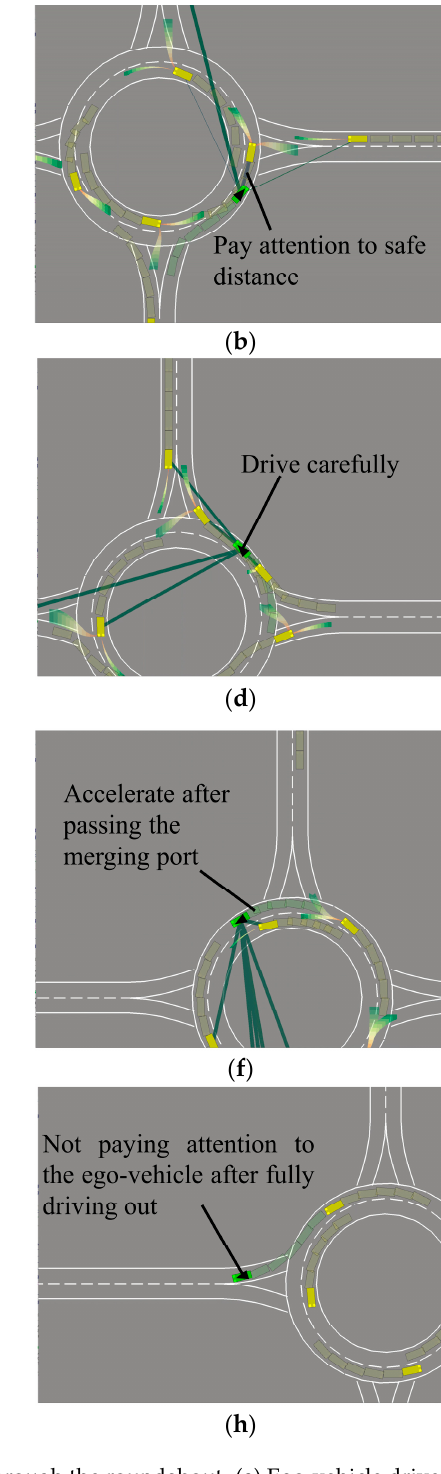
Figure 13. IP-SAC policy control ego-vehicle through the roundabout. ( a ) Ego-vehicle drive into the roundabout. ( b ) Ego-vehicle follow the front vehicle. ( c ) Ego-vehicle focus on incoming vehicles. ( d ) Ego-vehicle drive carefully. ( e ) Ego-vehicle slow down at merge port. ( f ) No obstacle vehicles ahead ego-vehicle accelerate. ( g ) Ego-vehicle is exiting the roundabout. ( h ) Ego-vehicle completely out of roundabout.